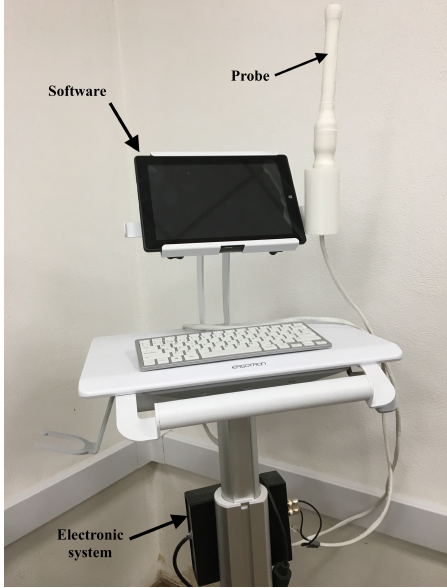
Figure 2. The prototyped TW probe.